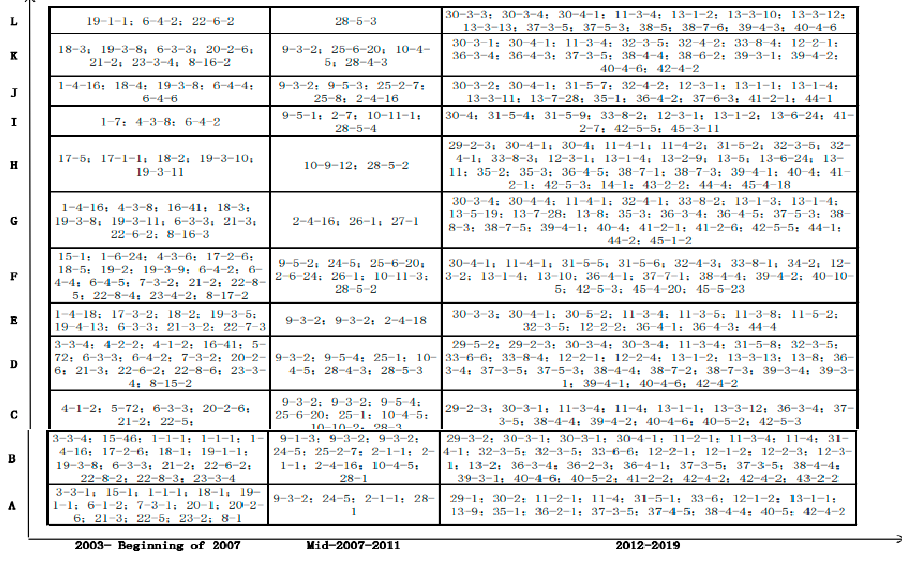
Figure 2. Distribution of policies by form. Table 4. Embeddedness of analysis codes in policy